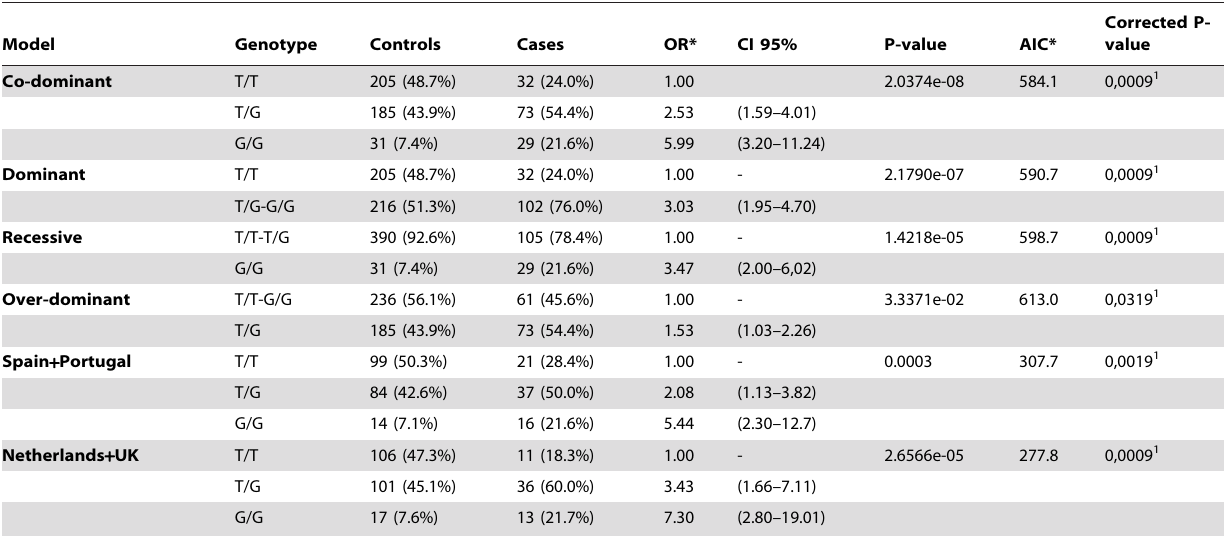
Table 3. Models of inheritance in the global sample.